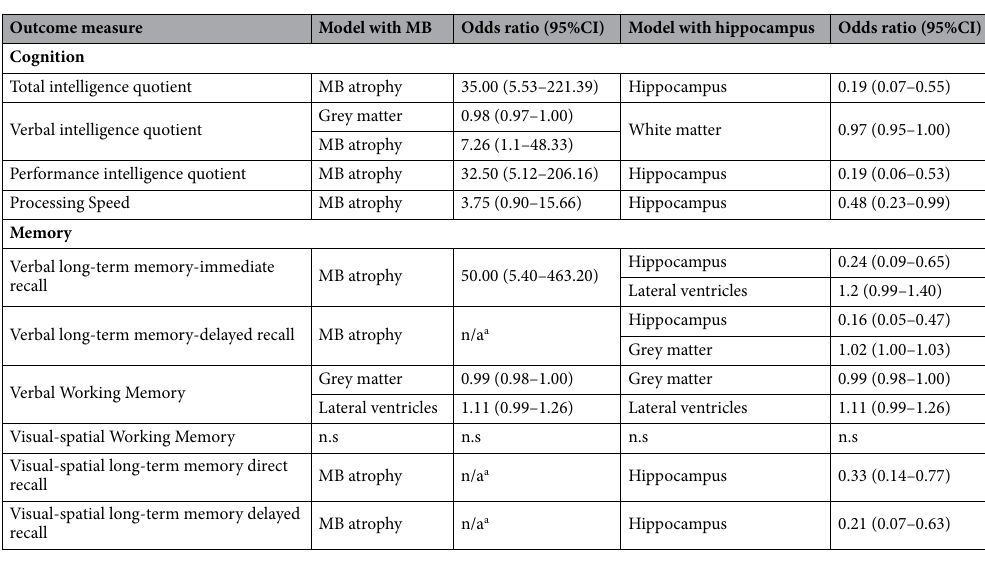
Table 4. Multivariable logistic regression models for different neuropsychological tests with MB and with total hippocampal volume. a No Odds Ratio’s could be calculated, because none of the infants with atrophy of the MB had a normal